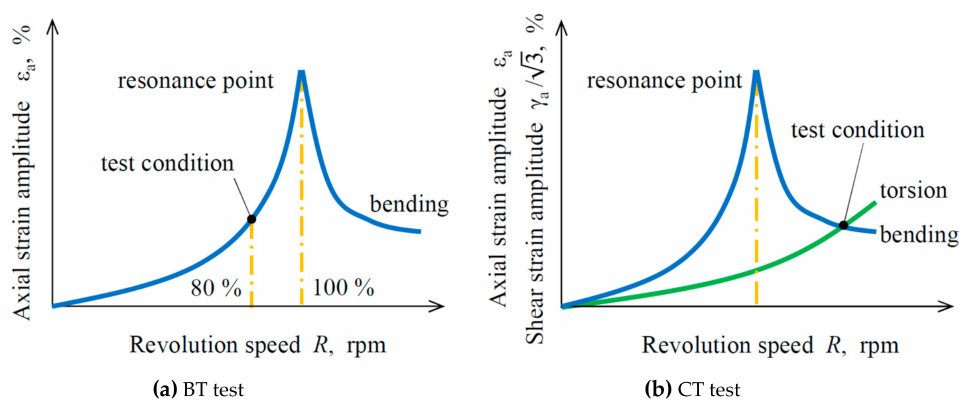
Figure 5. Relationships among ∆ ε , ∆ γ and R.